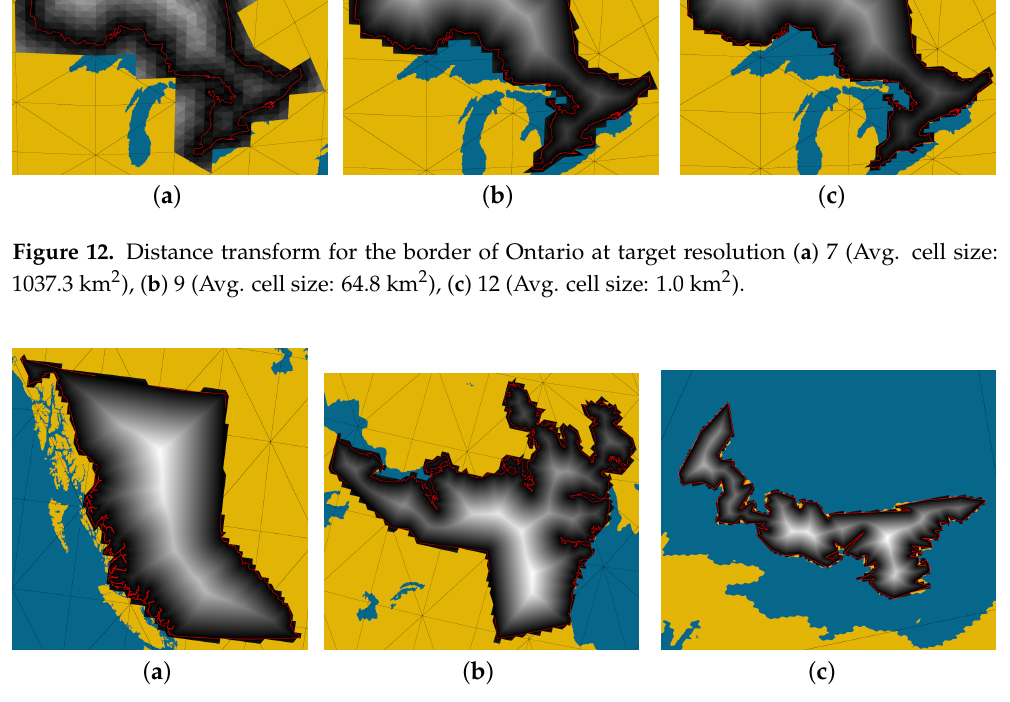
Figure 13. Distance transform for the border of ( a ) Mainland British Columbia and ( b ) Nunavut at target resolution 11 (Avg. cell size: 4.0 km 2 ), and ( c ) Price’s Edward Island at target resolution 15 (Avg. cell size: 0.016 km 2